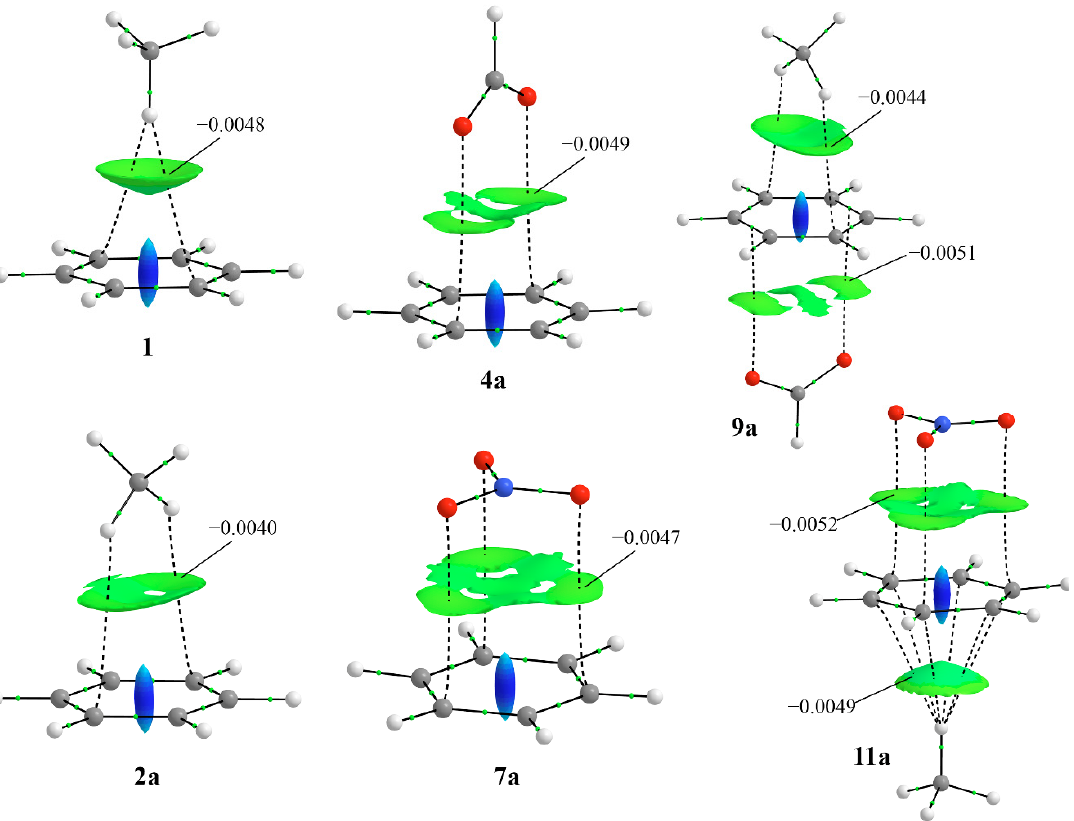
Figure 7. NCIPLOT gradient isosurfaces (isovalue = 0.5 au) for CH/ π complexes 1 and 2a ( left ), anion– π complexes 4a and 7a ( center ), and three-component complexes 9a and 11a ( right ). Green and blue indicate weak and strongly repulsive interactions, respectively. Values of sign( λ 2 ) ρ indicated are in au. Carbon, nitrogen, oxygen, and hydrogen atoms are indicated in grey, blue, red, and white color, respectively. Intermolecular bond paths are shown as dashed